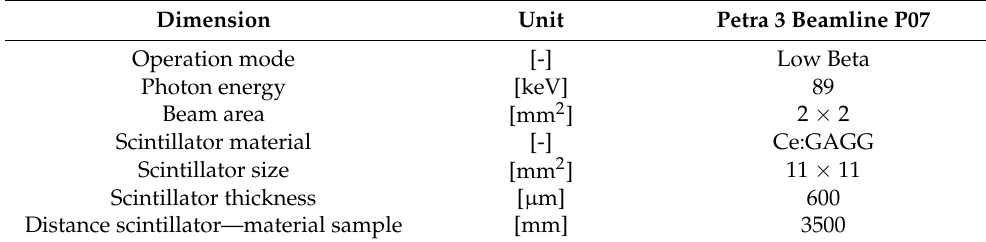
Table 1. Synchrotron setup and parameters for the experimental investigation.